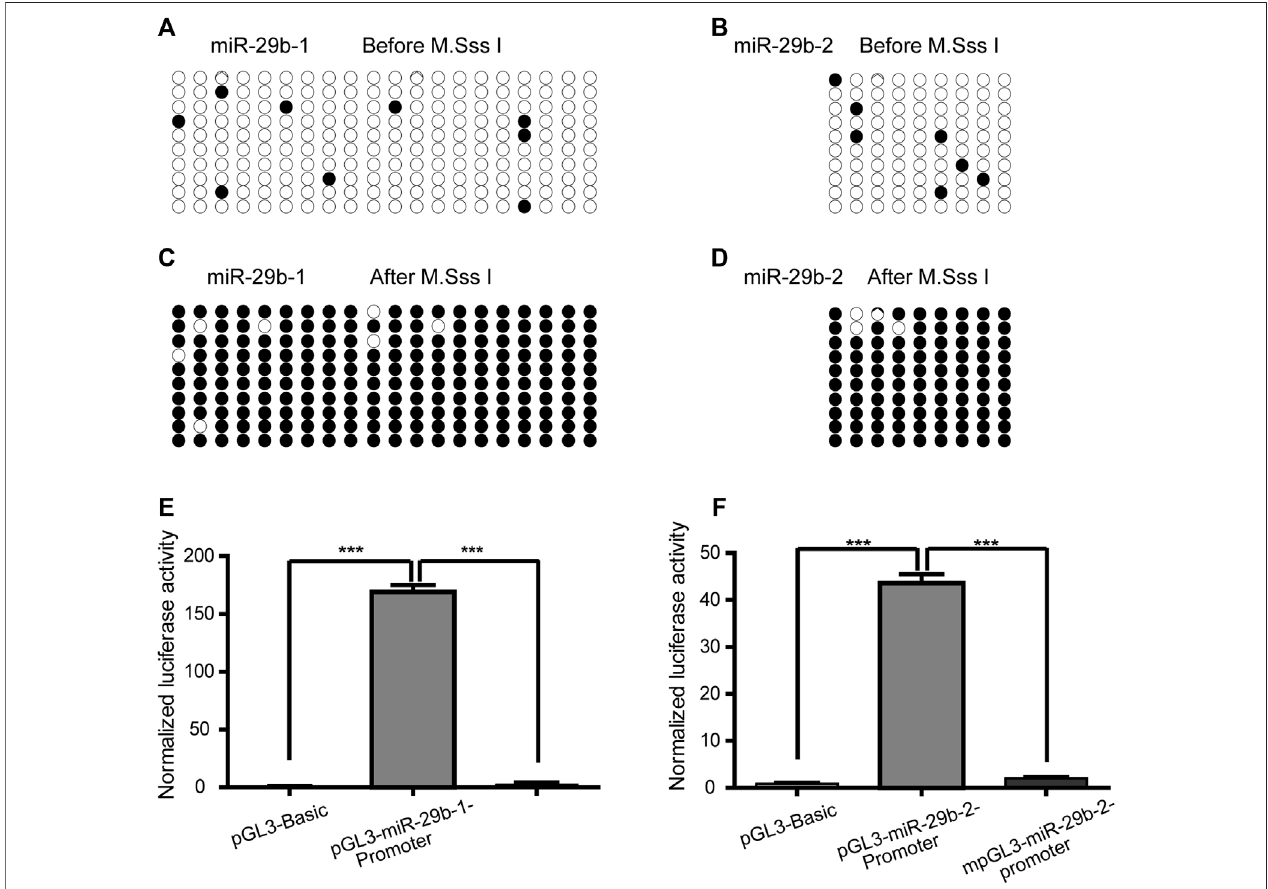
FIGURE 4 | The effect of promoter hypermethylation on the expression of miR-29b-3p. (A and B) The methylation levels of the pGL3-miR-29b-1 promoter and pGL3-miR-29b-2 promoterbeforeM. SssItreatment. Foreach plasmid, themethylationstatus ofCpG units isshown forten clones.Blackand whitecircles indicate the methylated and unmethylated CpG units, respectively. (C and D) The methylation levels ofthe pGL3-miR-29b-1 promoter and pGL3-miR-29b-2 promoter after M. SssI treatment. (E) The effect of methylation on the transcriptional activity of the − 873 bp to +158 bp region of the miR-29b-1 gene. (F) The effect of methylation on the transcriptional activity of the − 1407 bp to − 1173 bp region of the miR-29b-2 gene. ( ns not signi fi cant, * p < 0.05, ** p < 0.01, *** p < 0.001, and **** p < 0.0001).